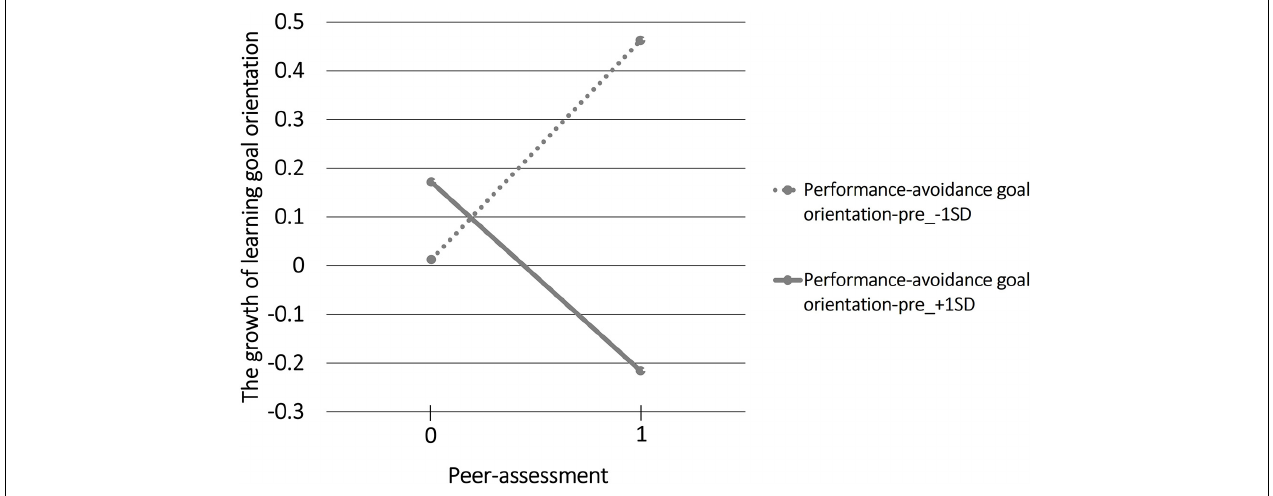
FIGURE 3 | The regression line of peer-assessment to the growth of learning goal orientation with performance-avoidance goal orientation-pre as the moderating